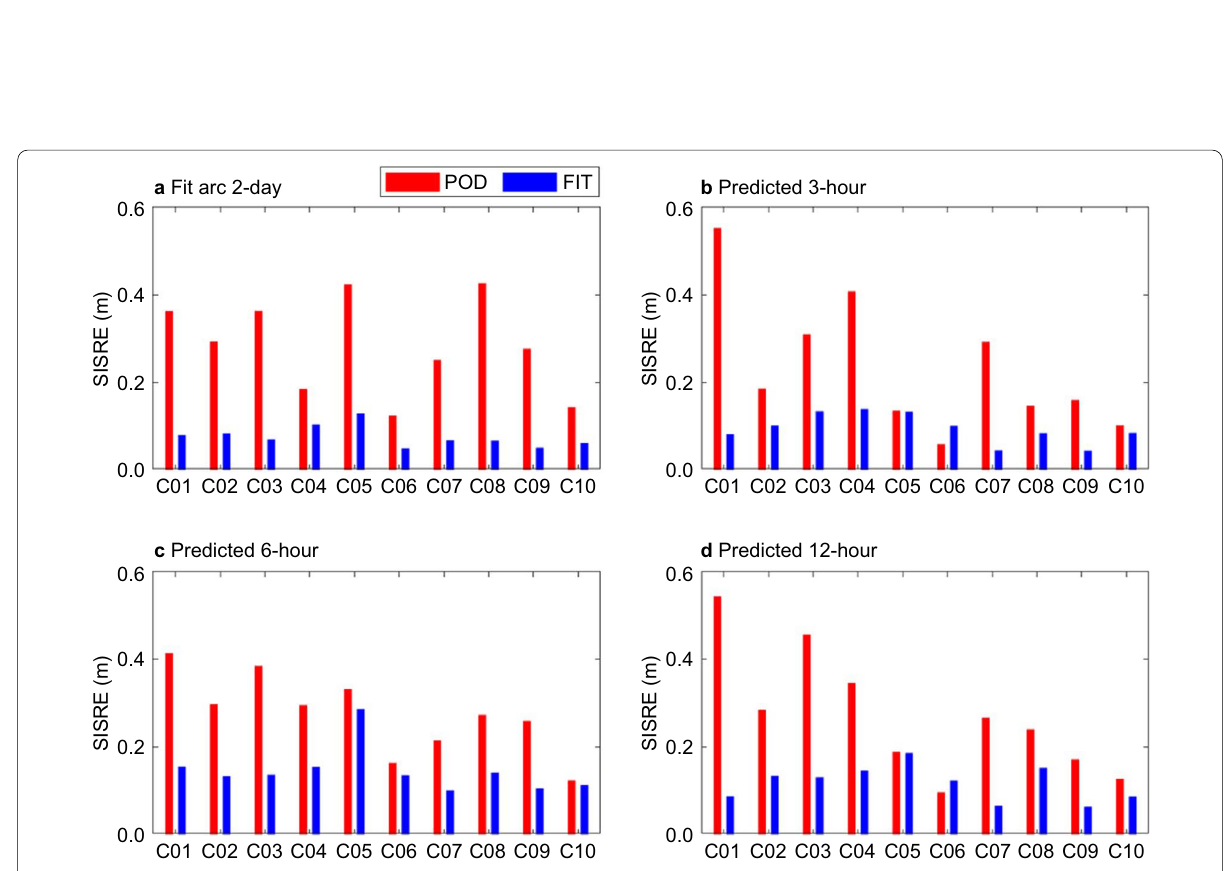
Fig. 6 Orbit-only SISRE of the original ODTS orbits (POD), refined orbits (FIT) of 2-day ODTS arc, 3-h, 6-h, and 12-h prediction arcs for each satellite, where POD refers to ODTS orbits and FIT refer to refined orbits and the